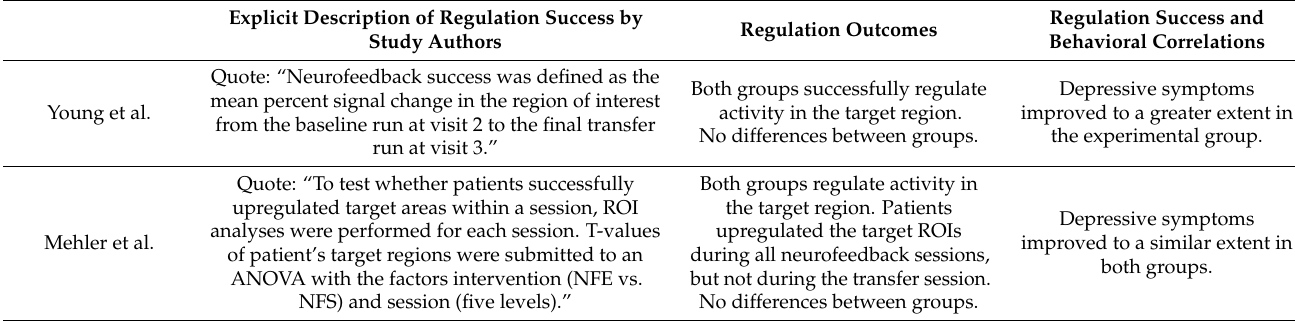
Table 5. Description of regulation success